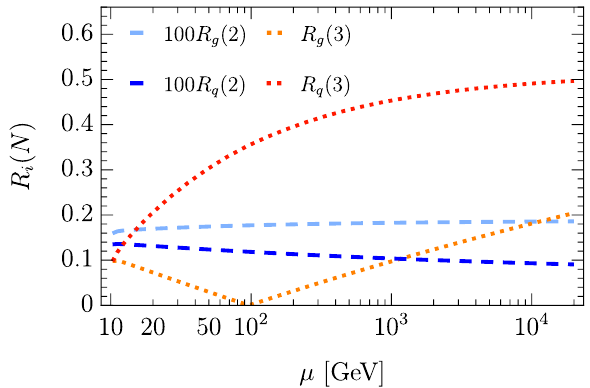
Figure 2. The ratio defined in eq. (5.3) for the quark (darker) and gluon (lighter) second (blue dashed) and third (orange dotted) central moments as a function of the renormalization scale µ . Note that the ratio for the second moment has been amplified by a factor 100 such that it is visible in this plot. The effect of ∆ on the evolution of the second central moment is much smaller than for the higher moments because ∆ appears only squared in the evolution for σ (2) , while for the other moments terms linear in ∆ are also